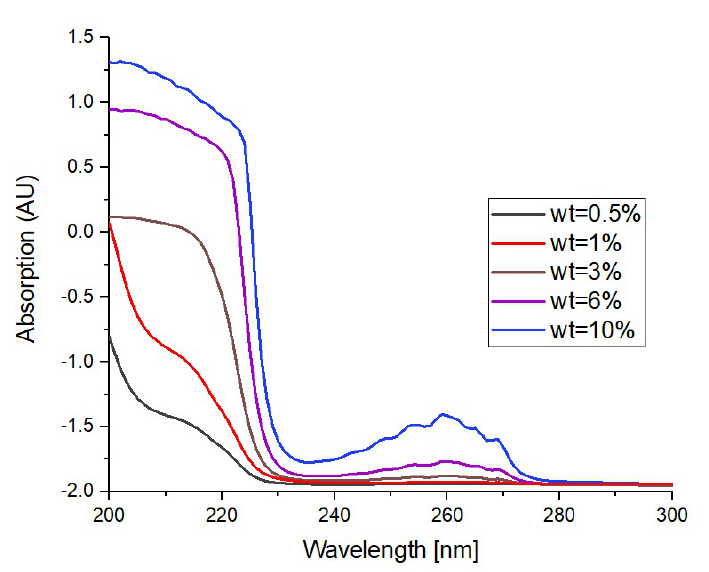
Figure 2. Absorbance of fabricated PSAN thin films as a function of wavelength and PSAN concen-